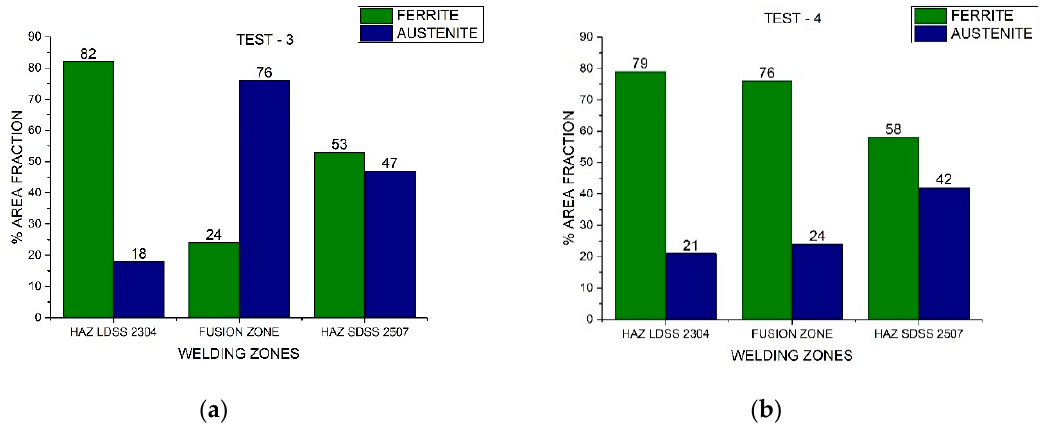
Figure 7. Area fraction through the distinct welded zones: ( a ) Test #1 and ( b ) Test #2.